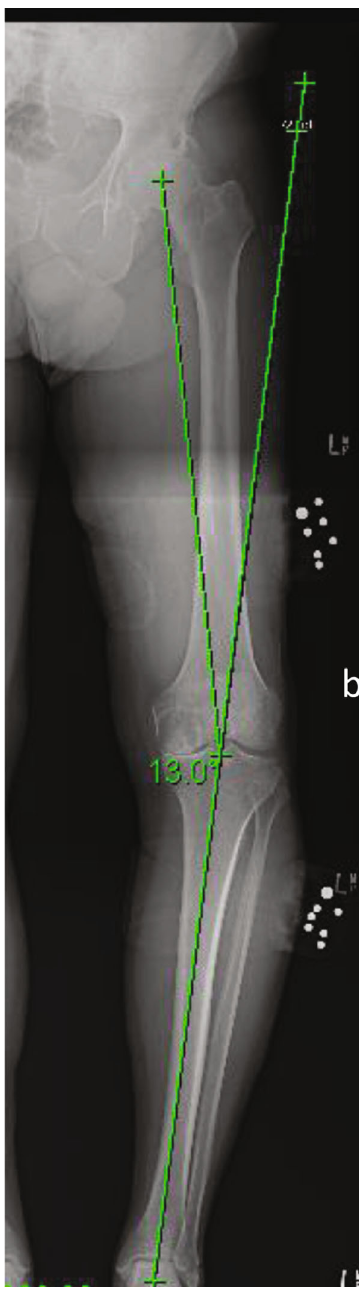
Figure 8: Preoperative long-leg X-ray showing the weight-bearing functional alignment with 13.0 degrees of varus and osteoarthritis of the left knee for Case